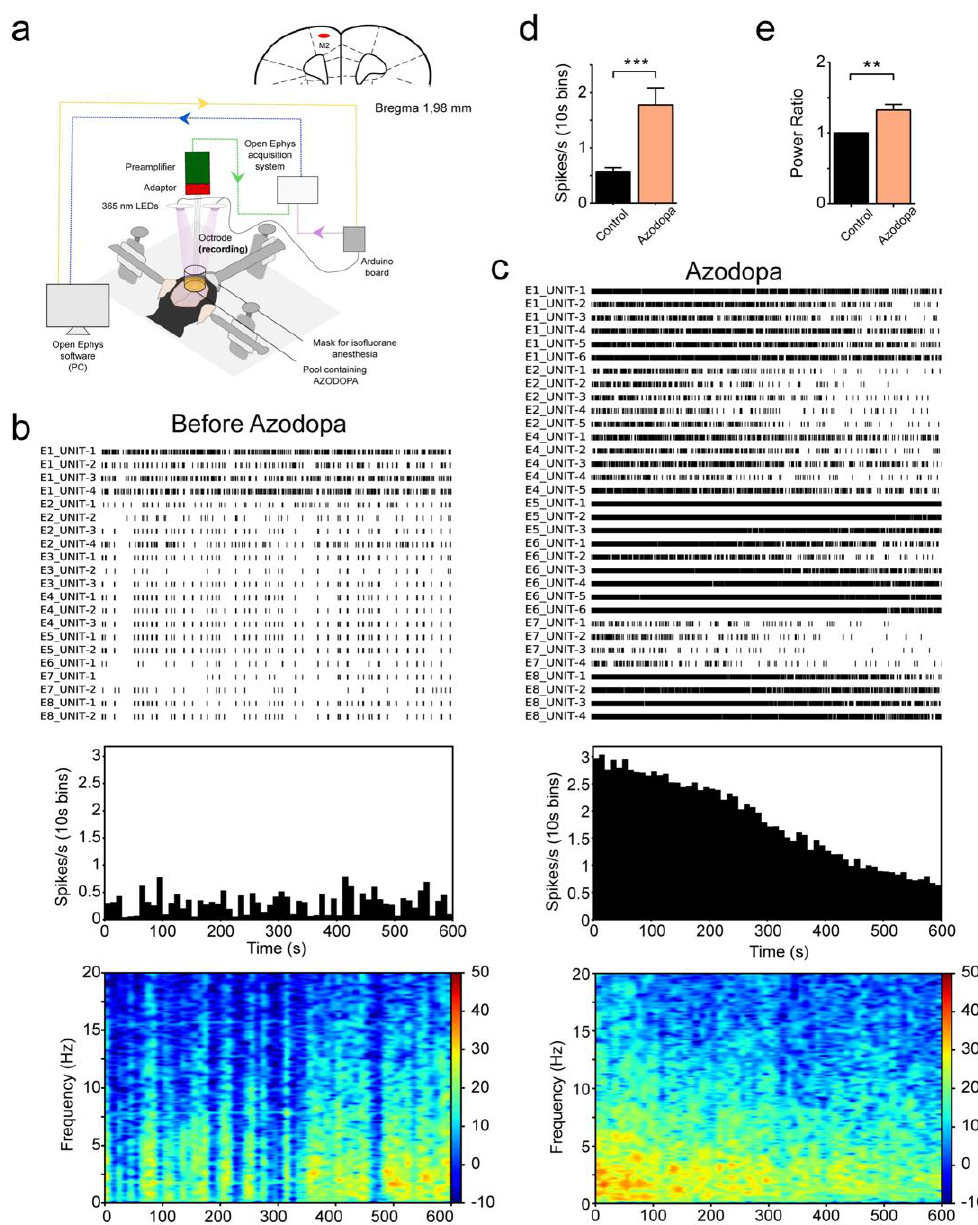
that spikes from different neurons co-occurred altering the shape of the waveforms and thus prevented their classification. Corresponding with the increased spiking activity of changes in firing rate (Figure 4c, bottom panel). Statistical analyses confirmed significant increases of firing rate and 1–10 Hz power when combining the two animals (Figure 4d,e).